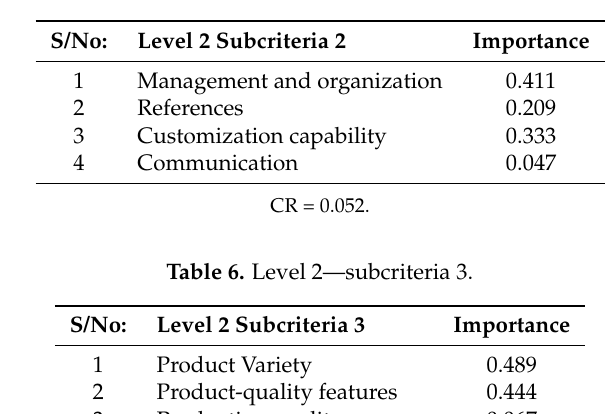
Table 5. Level 2—subcriteria 2.